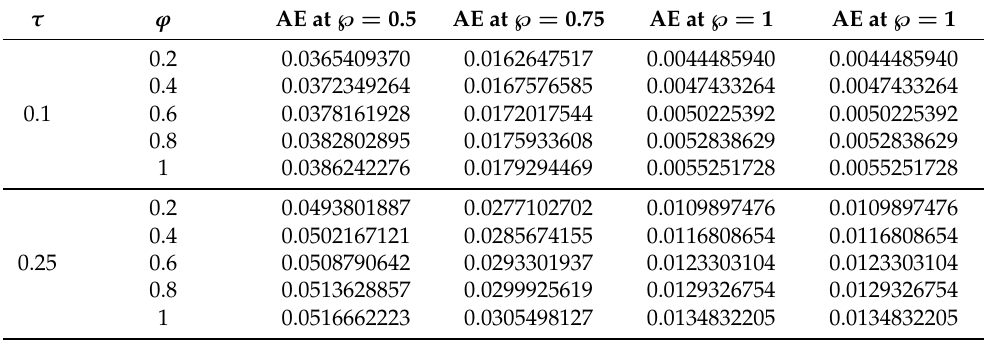
Table 2. Numerical analysis of v ( ϕ , τ ) of the example given in Example 1 with different values of ϕ , τ , and p = 2 3